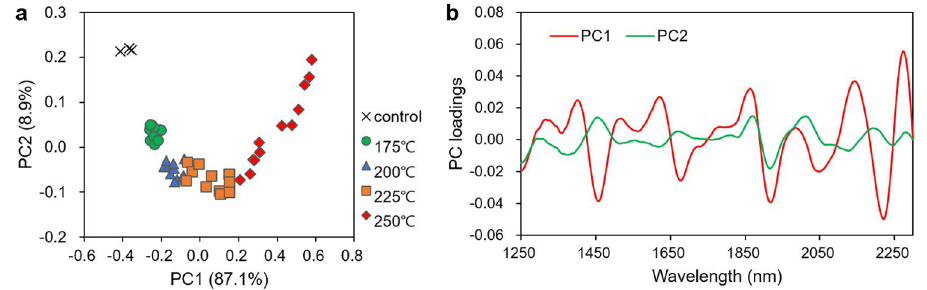
Figure 3. PCA score plot on first two PCs in second-derivative NIR spectra ( a ) and loadings of PCs ( b ). In score plot ( a ), percentages in parentheses of x- and y-axis titles are those of explained variables of corresponding PC.